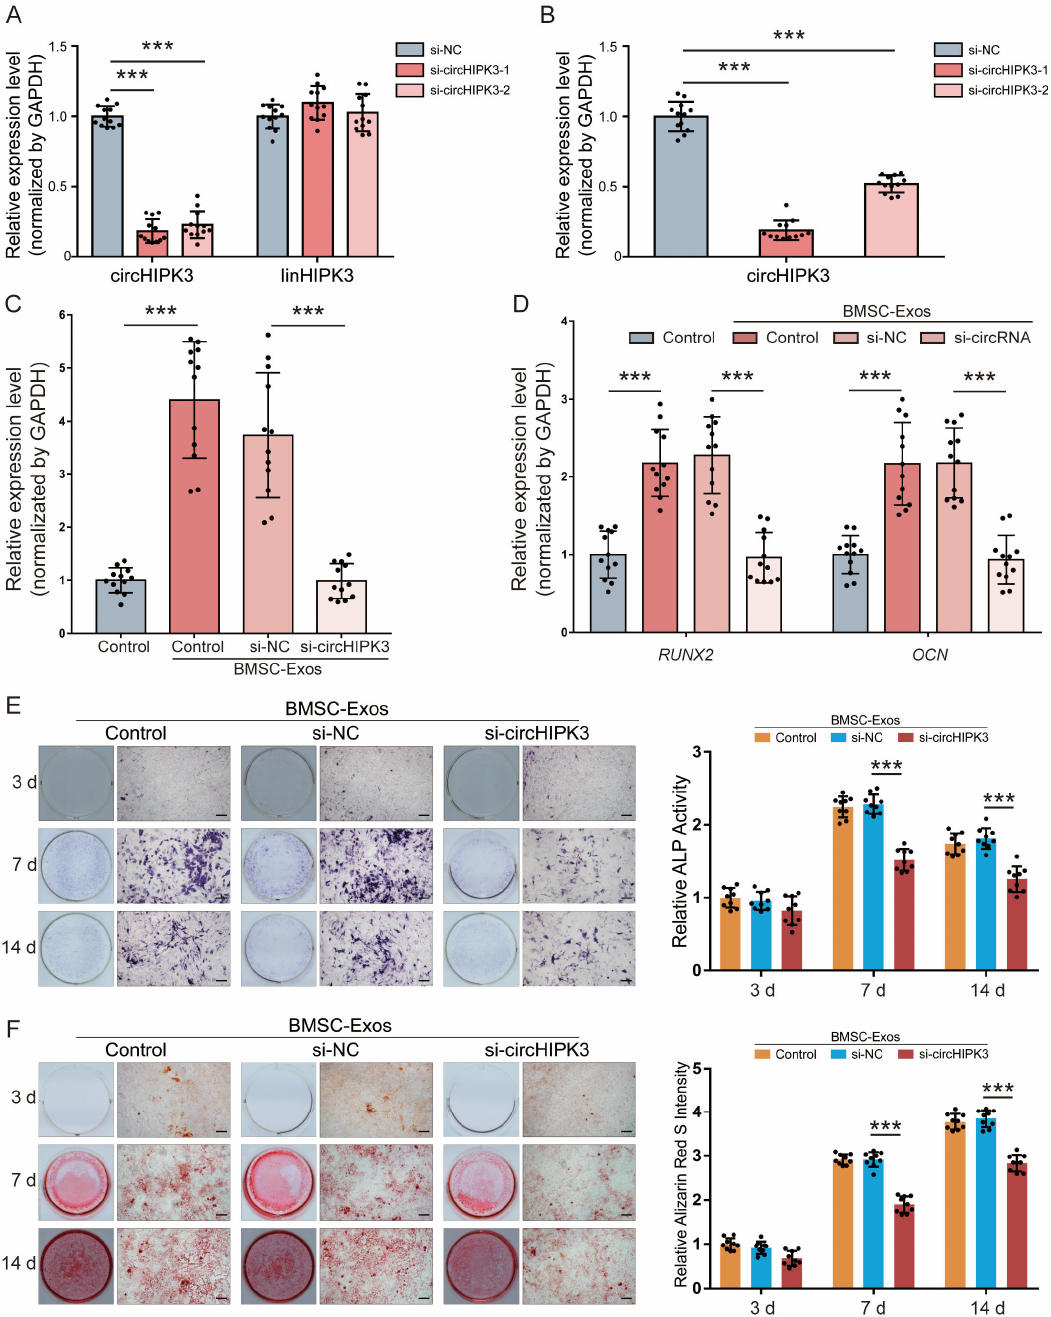
Figure 3. CircHIPK3 promoted osteogenic differentiation of MC3T3 ‐ E1 cells. ( A ) circHIPK3 levels and linear HIPK3 in BMSCs were measured by qRT ‐ PCR after transfection with si ‐ NC, si ‐ circHIPK3 ‐ 1 or si ‐ circHIPK3 ‐ 2. ( B ) circHIPK3 levels in exosomes derived from BMSCs treated with si ‐ NC, si ‐ circHIPK3 ‐ 1 or si ‐ circHIPK3 ‐ 2 were measured by qRT ‐ PCR. ( C , D ) circHIPK3 levels ( C ) and RUNX2 and OCN levels ( D ) in MC3T3 ‐ E1 cells treated with DMSO (control, n = 12) or exosomes derived from BMSCs treated DMSO (BMSC ‐ Exos ‐ control, n = 12), with si ‐ NC (BMSC ‐ Exos ‐ si ‐ NC, n = 12) or si ‐ circHIPK3 ‐ 1 (BMSC ‐ Exos ‐ si ‐ circHIPK3, n = 12). *** p < 0.001. ( E ) ALP staining (left) was examined and activity of ALP (right, n = 6) was analyzed by ALP activity assay kit. Bar 100 μ m. ( F ) ARS staining was performed (left) and quantified using a microplate reader at 562 nm (right, n = 6). Bar: 100 μ m. *** p < 0.001.